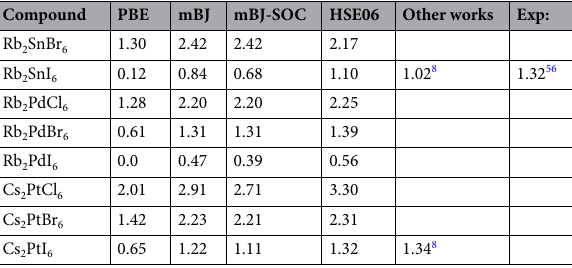
Table 2. Band gap calculated by different GGA exchange-correlation functionals for A 2 BX 6 (A = Rb, Cs; B = Sn, Pd, Pt; X = Cl, Br, I) compounds.